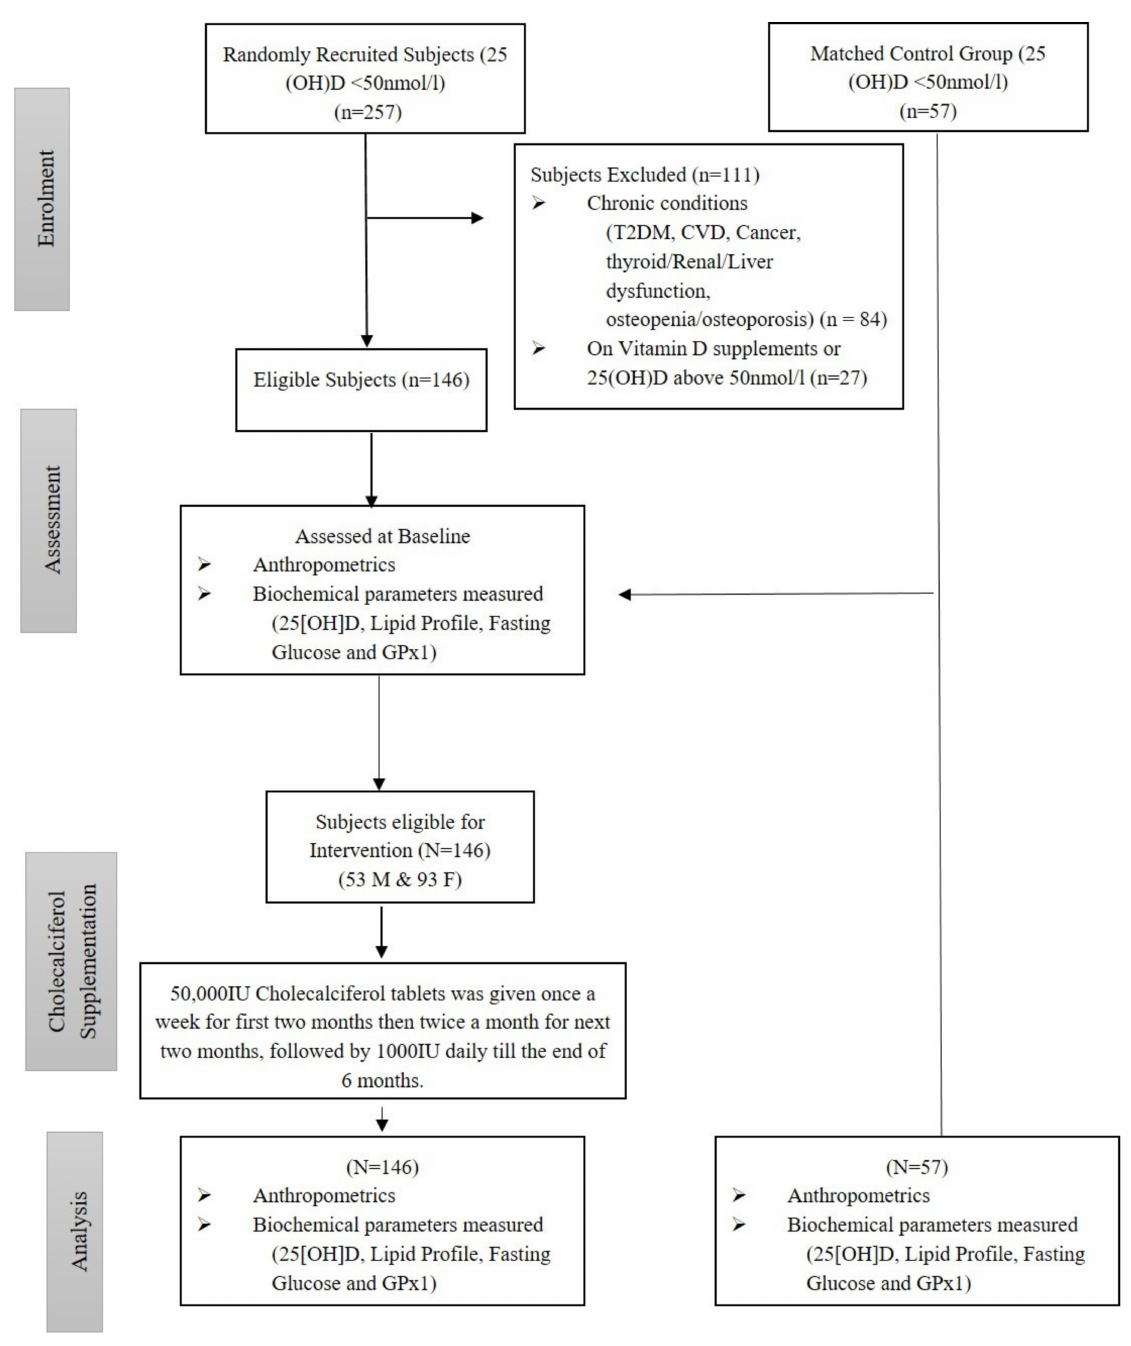
Figure 1. Modified CONSORT diagram for non-randomized